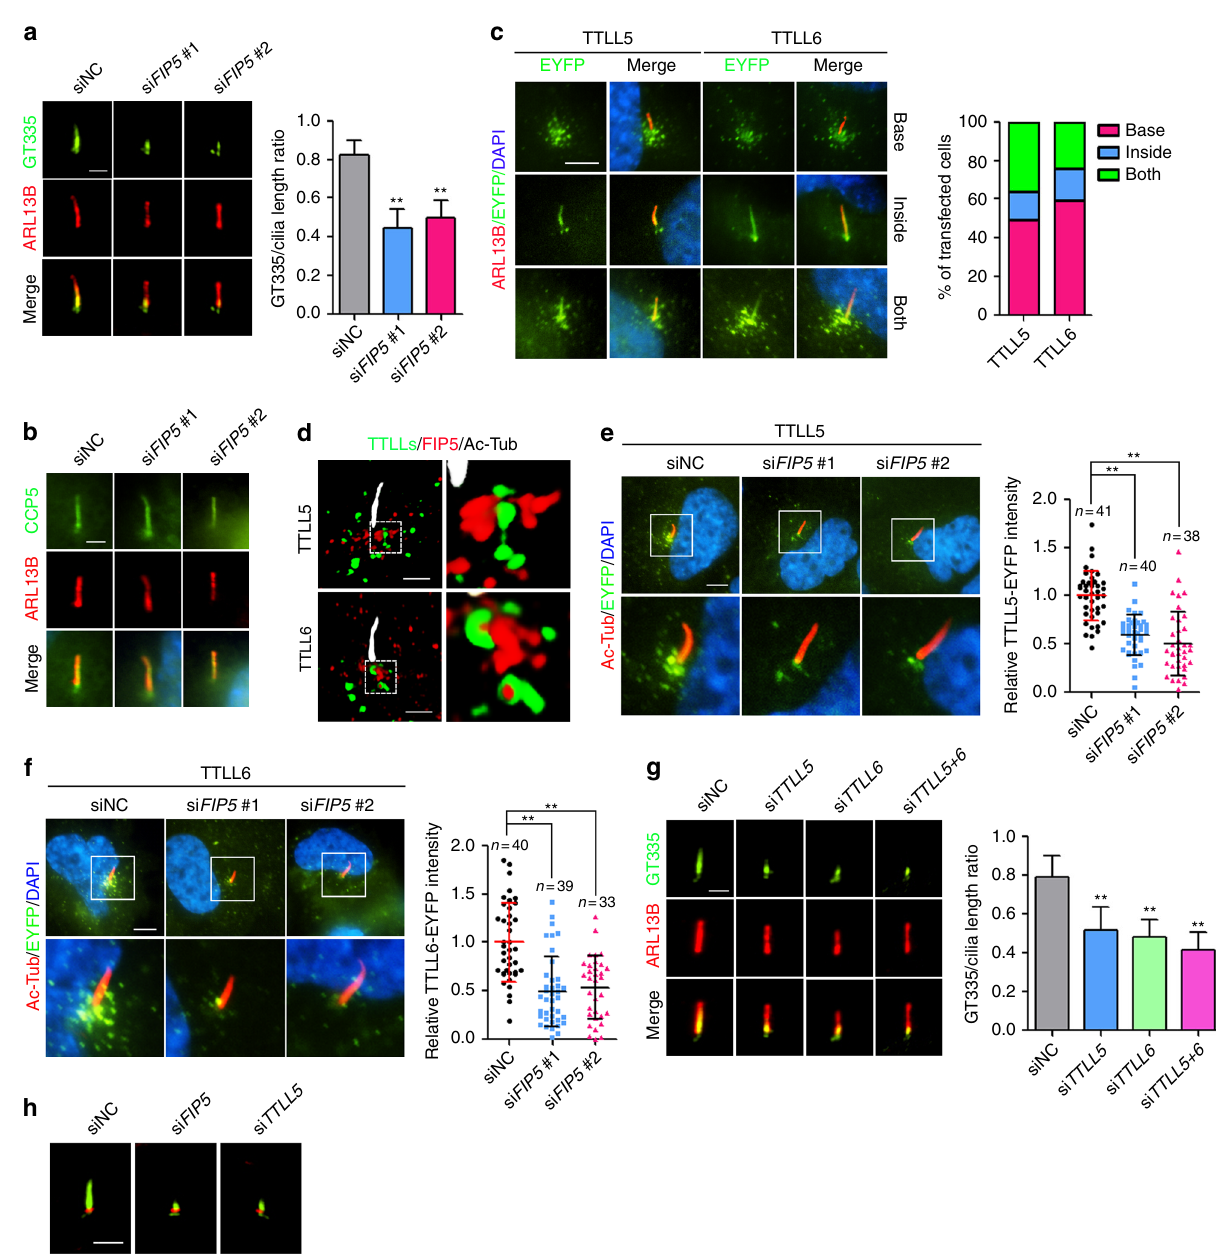
Fig. 2 ARL13B and FIP5 regulate axoneme polyglutamylation by controlling the ciliary import of glutamylase TTLL5 and TTLL6. a hTERT-RPE-1 cells were treated with indicated siRNAs for 48 h and serum starved for 24 h. Axoneme polyglutamylation was immunostained by antibody GT335. ARL13B was used as a ciliary marker. (right) Quantitation of the (GT335 staining)/(Cilia length) ratio (siNC: n = 43, siFIP5#1: n = 39, siFIP5#2: n = 41 cilia). b CCP5 ciliary localization was not affected by FIP5 depletion. hTERT-RPE-1 stable cells expressing CCP5-EYFP were treated with indicated siRNAs for 48 h, staved for 24 h. c TTLL5 and TTLL6 were detected inside cilia and on vesicle-like organelles at the ciliary base. hTERT-RPE-1 stable cells expressing TTLL5-EYFP and TTLL6-EYFP were starved for 24 h. Quanti fi cation of the percentage of different TTLL5/6 localization patterns in transfected RPE cells ( n = 50 cilia). d SIM images show that FIP5-positive vesicles (Red) associate with TTLL5- or TTLL6-positive vesicles (Green) at the ciliary base of hTERT-RPE-1 stable cells expressing TTLL5-EYFP and TTLL6-EYFP. Enlarged image of the box area in left panel. e , f Depletion of FIP5 abolished the enrichment of TTLL5- ( e ) or TTLL6-positvie ( f ) vesicles at the ciliary base. hTERT-RPE-1 stable cells expressing TTLL5-EYFP and TTLL6-EYFP were treated with the indicated siRNAs for 48 h and serum staved for 24 h. Quanti fi ed of TTLL5/6-EYFP total intensity at cilia base (30 μ m 2 area were measured). g Depletion of TTLL5 or TTLL6 impaired axoneme polyglutamylation. Quanti fi ed data shown in right panels (siNC: n = 39, siTTLL5: n = 35, siTTLL6: n = 36, siTTLL5 + 6: n = 38 cilia). h The residual polyglutamylation locates above transition fi bers, presumably at the transition zone. hTERT-RPE-1 cells were treated with indicated siRNAs for 48 h and serum starved for 24 h. FBF1 was used as a marker of transition fi bers. ARL13B, Ac-Tub, FIP5, FBF1 and glutamylation were immunostained by antibodies. TTLL5/6-EYFP and CCP5-EYFP was shown by direct fl uorescence. Scale bars in a , b , d , g and h are 2 μ m. Scale bars in c , e and f are 5 μ m. Center values represent mean. Error bars represent s.d. N values: cilia number accessed from at least six fi elds. Statistical signi fi cance was determined using unpaired Student ’ s t test. ** p <